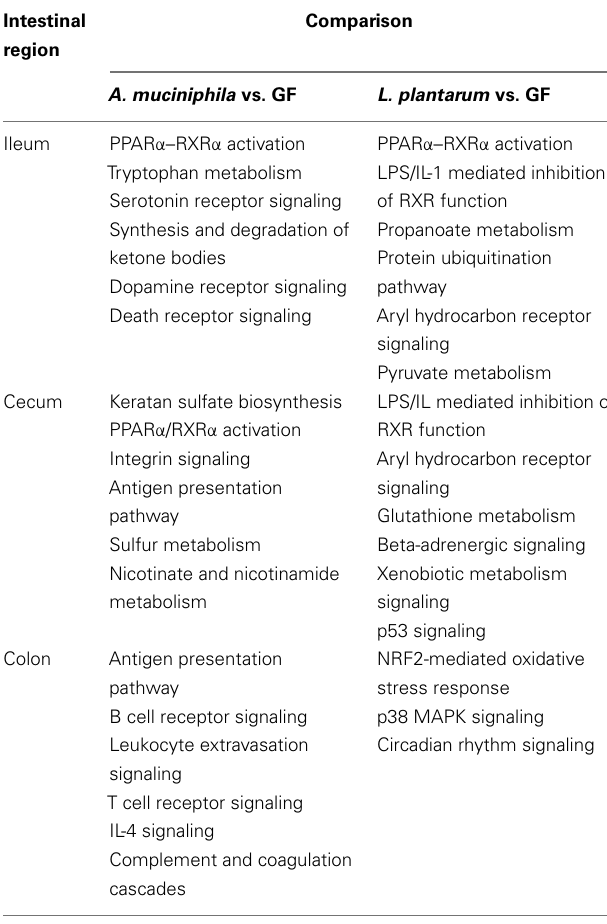
Table 3 | Canonical pathways in the mouse ileum, cecum, and colon that are more significantly modulated upon colonization by A. muciniphila or L. plantarum